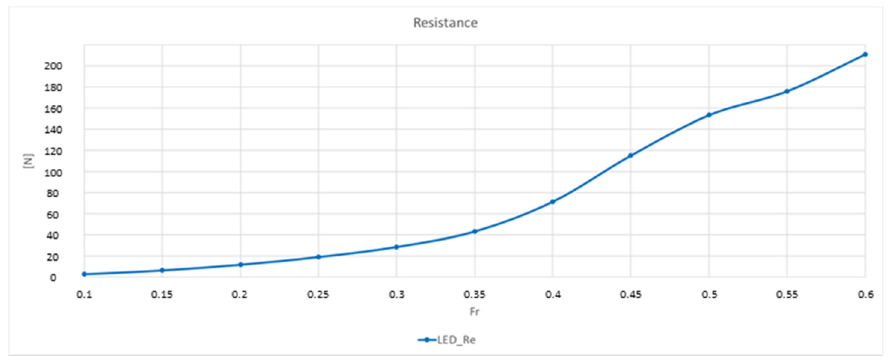
Figure 13. Resistance curve of the hull of a sailboat.